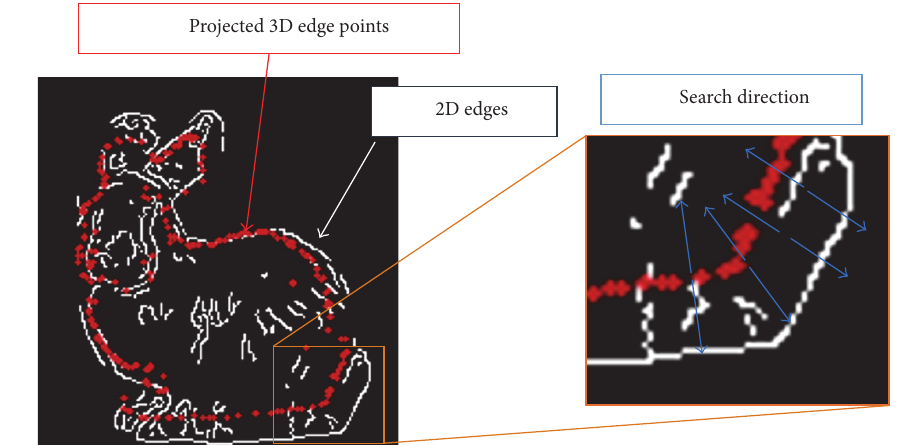
Figure 5: Search for corresponding